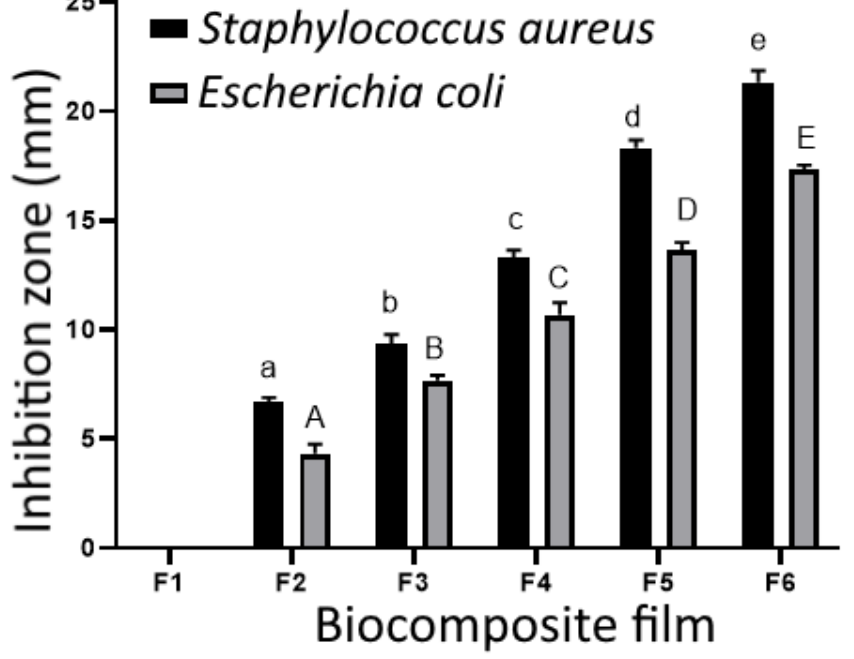
Figure 5. Inhibitory effects of the biocomposite films on Escherichia coli and Staphylococcus aureus. The same color bars with different letters are statistically different ( p < 0.05) according to Tukey honestly significant difference test. For sample codes F1 to F6, refer to Table 1.